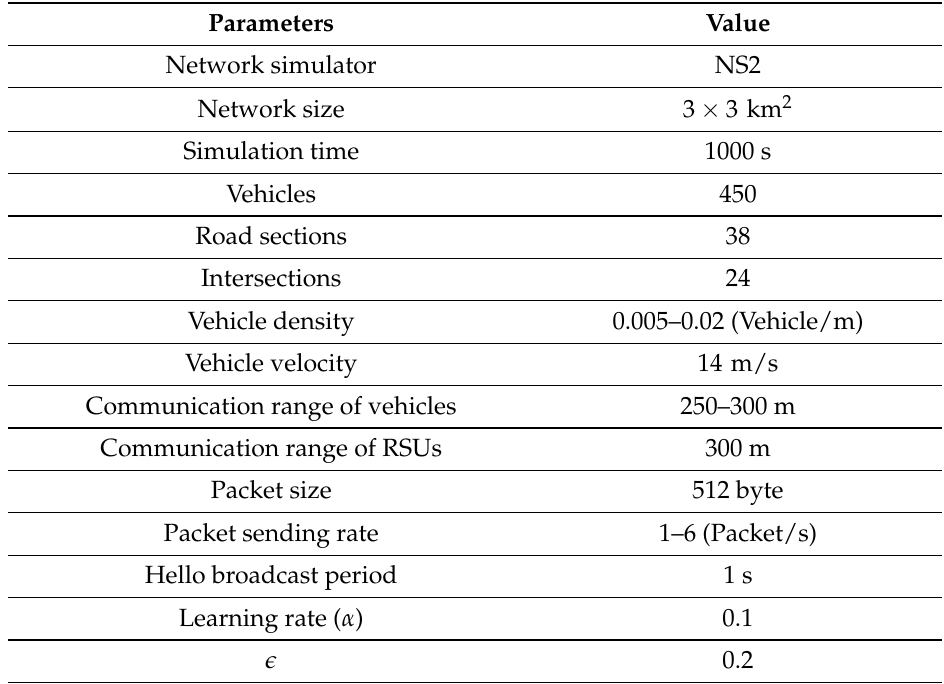
Table 5. Simulation